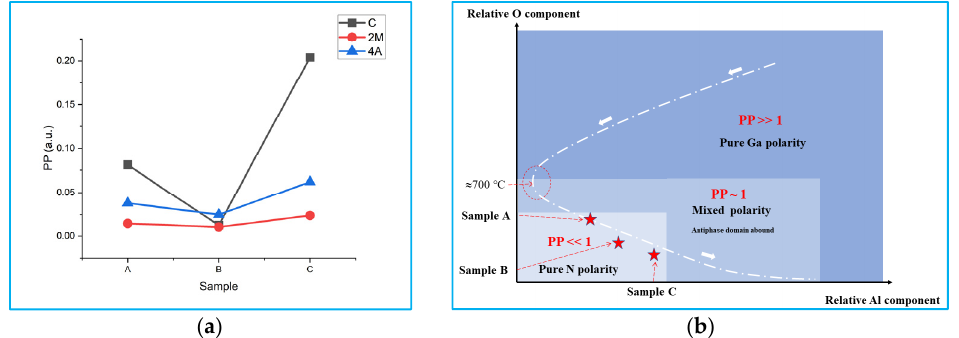
Figure 5. The calculated PP values of all samples: ( a ) polarity phase diagram of GaN film grown on a sapphire substrate and the relative O and Al components during the nitriding process; ( b ) the white, dotted line is the intentional nitriding curve, and the white arrows point to the direction of the increasing nitriding temperature. The positions of the three samples are marked by red five-pointed stars.